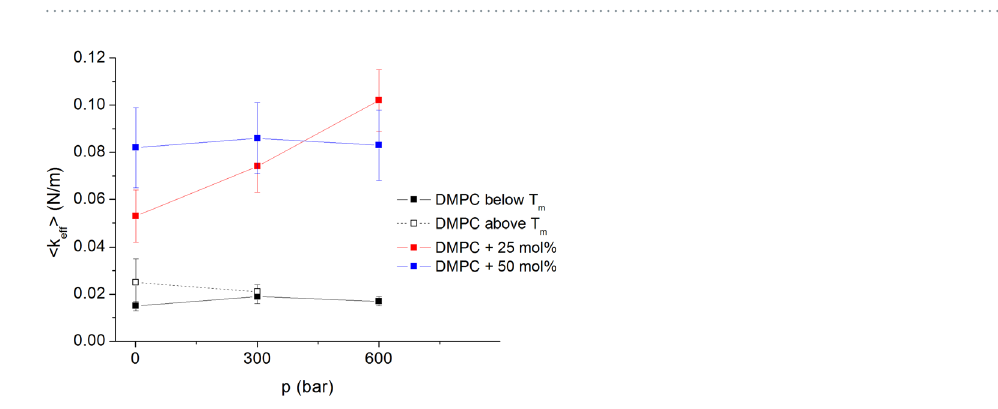
Figure 3. MSD of pure DMPC (reproduced from ref. 31 ) and both DMPC/cholesterol mixtures calculated according to eq. (17) (without any polydispersity and C α ( τ ) = 0). Black squares represent data at atmospheric pressure, red circles correspond to 300 bar and blue triangles to 600 bar. The lines show the fits according to eq. (20) and the effective force constants are calculated with the help of eq. (21). For 0 mol% cholesterol, the dotted lines in the transition region are only guide to the eyes. The vertical lines mark the phase transition temperature at that pressure value.